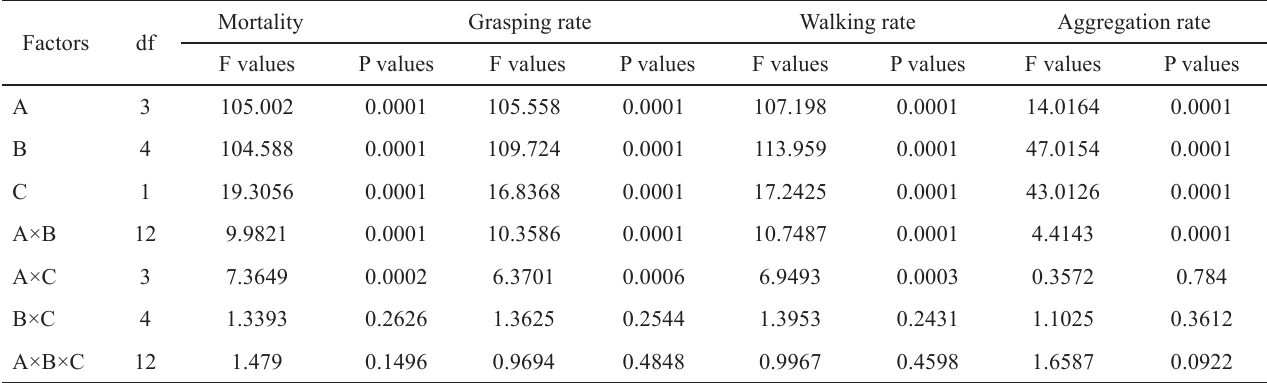
Table 1. ANOVA for the main factors of the fumigation test affecting the behaviors of RIFA.